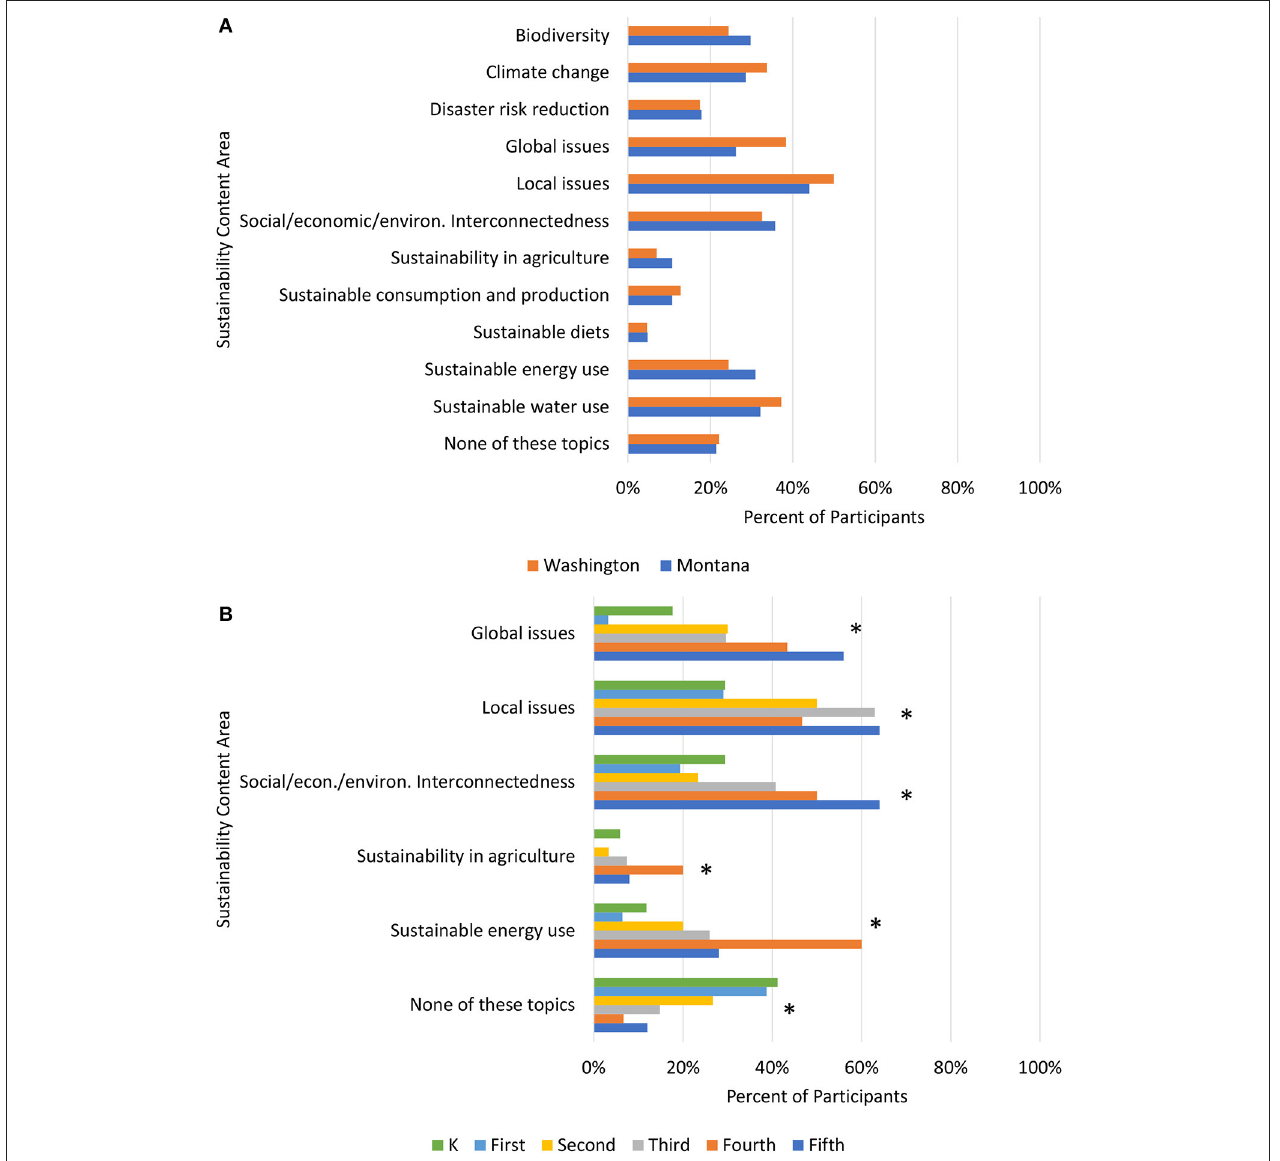
FIGURE 2 | Percent of participants (A) from Washington ( n = 86) and Montana ( n = 84) and (B) that teach each grade level that report teaching about each sustainability-related content area (K n = 17, 1st n = 31, 2nd n = 30, 3rd n = 27, 4th n = 30, 5th n = 25). Asterisks represent significant